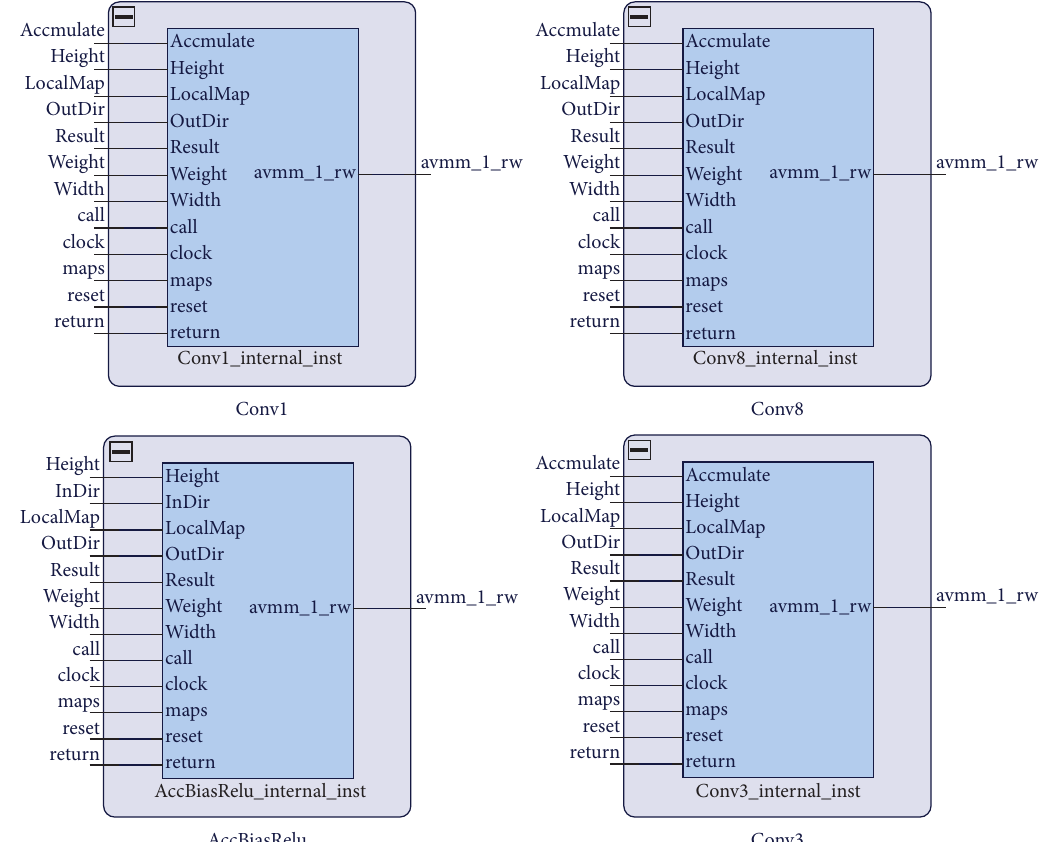
Figure 7: Convolution kernel IP and ReLu function IP core.